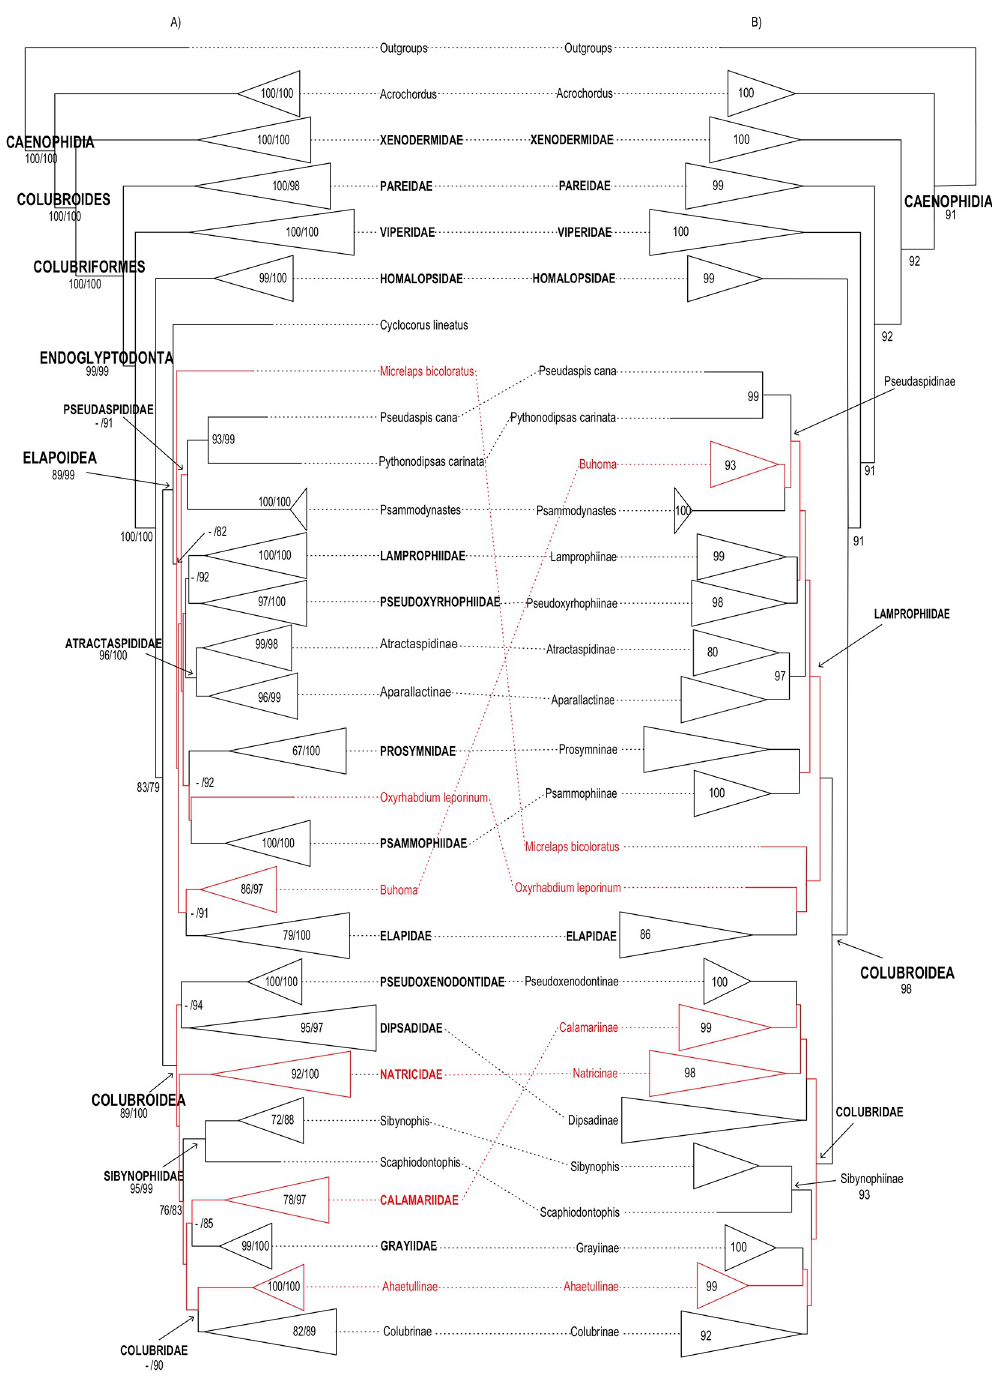
Fig 3. Higher-level caenophidian phylogenies. Comparison between Maximum-likelihood phylogenetic estimates from (A) the present study and (B) Zheng and Wiens [27]. Tips represent commonly recognized families, subfamilies and rogue taxa. Names in red correspond to taxa with distinct phylogenetic positions in the topologies compared. Numbers on each branch and within expanded tips correspond to our and previously reported support values: (A) FBP (left) and SHL (right); (B) FBP. Branches without numbers have support <